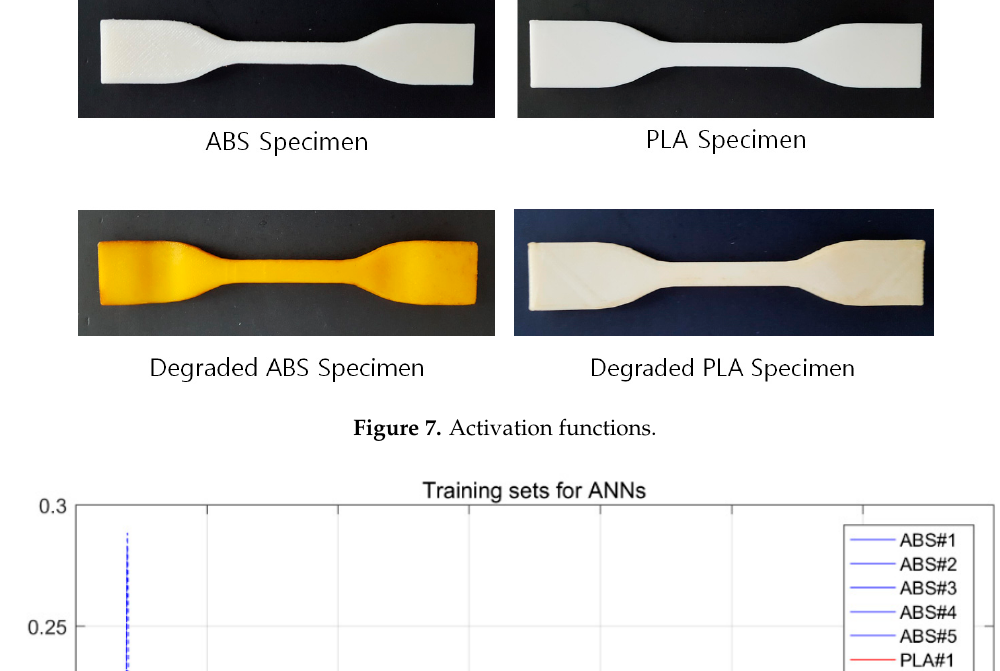
Figure 8. Twenty training sets for ANNs.